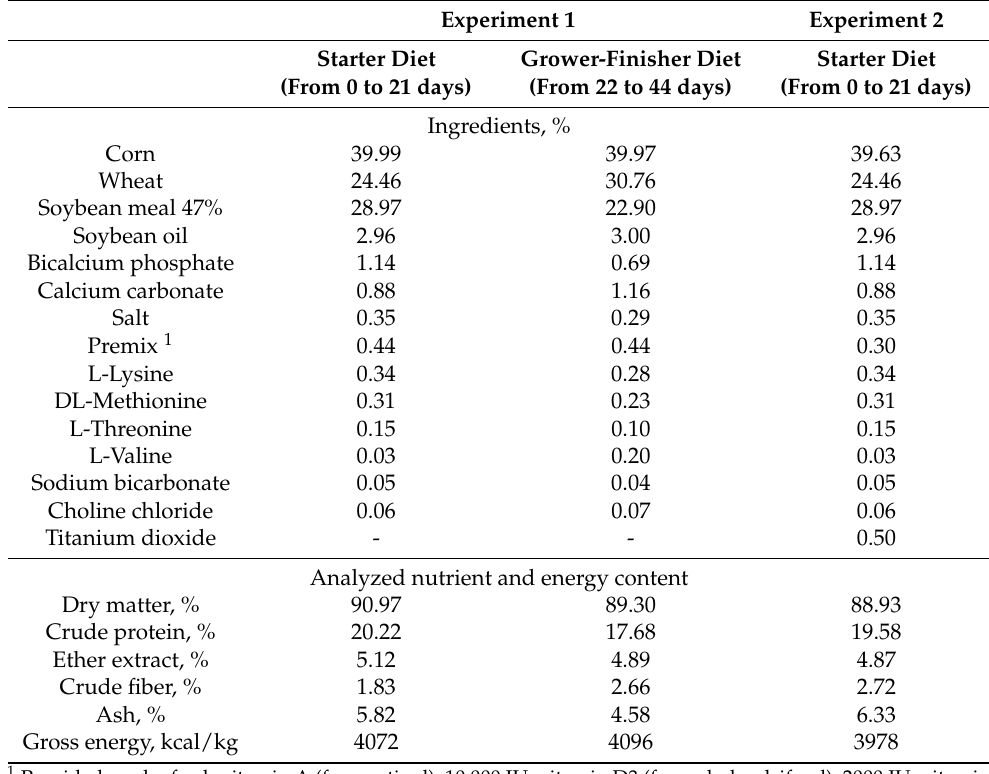
Table 1. Ingredient composition and chemical analysis of the basal diets, as-fed basis (Experiment 1 and Experiment